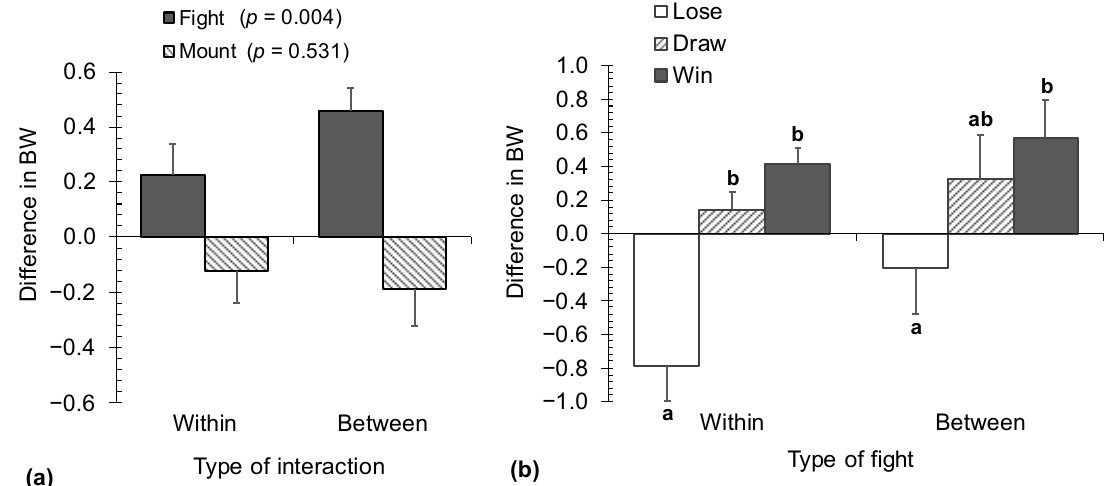
Figure 5. Body weight asymmetry in within- and between-litter interactions in relation to ( a ) behaviour type (fighting, mounting) and ( b ) outcome of fight (win, draw, lose); BW—body weight. Values marked with different superscript letters differed significantly by p < 0.05 (among outcomes within type of fight).